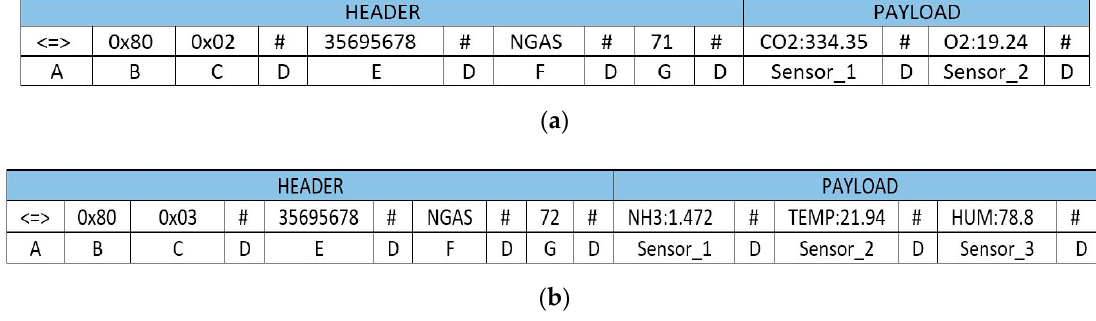
Figure 8. Frame in networked mode with gas sensors data: ( a ) Frame with data from two sensors. ( b ) Frame with data from three sensors.